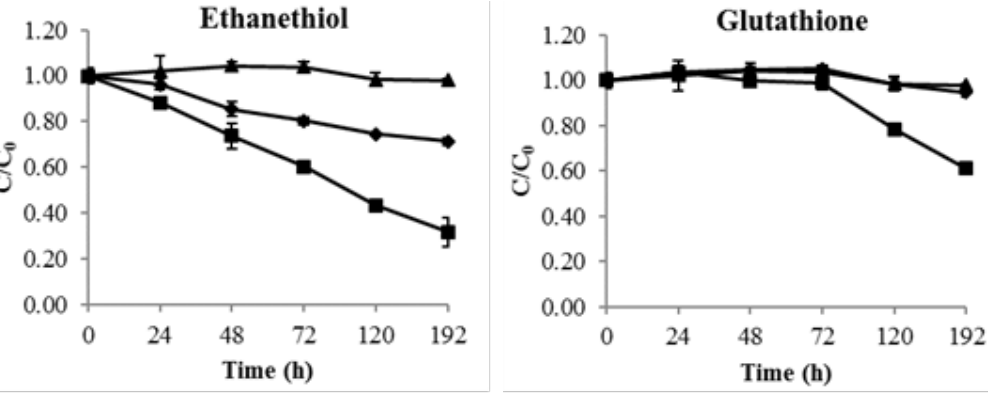
Figure 5. Thiols (ethanethiol and glutathione) consumption by mannoproteins, thiol control ( ◆ ), thiol + mannoprotein ( ■ ), mannoprotein control ( ▲ ).